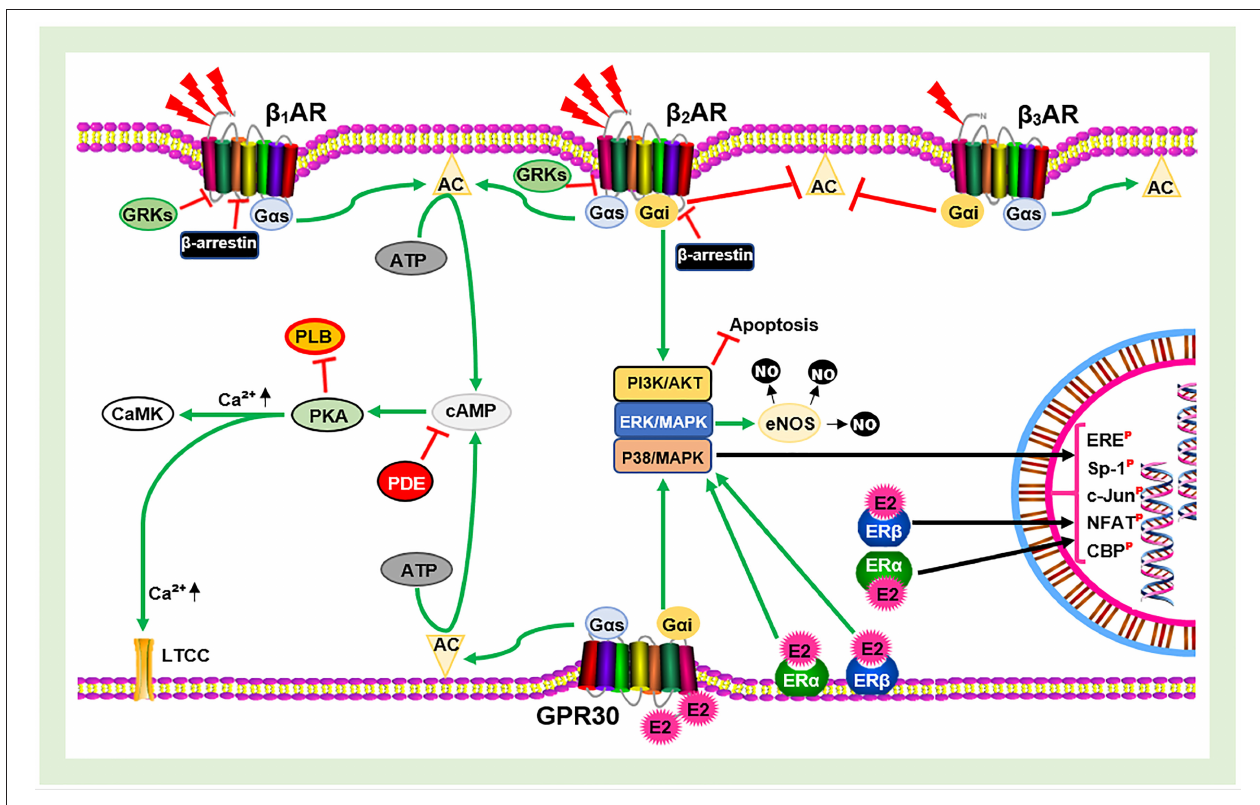
FIGURE 1 | Schematic illustration of estrogen receptors (ERs) and β -adrenergic receptors ( β ARs) signaling. AC, Adenylyl cyclase; cAMP, cyclic adenosine monophosphate; PKA, protein kinase A; GRKs, G-protein-coupled receptor kinases; E2, estrogen; eNOS, endothelial nitric oxide synthase; NO, nitric oxide; PDE, phosphodiesterase; PLB, phospholamban; LTCC, L-type calcium channel; CaMK, calmodulin-dependent kinase; ERE, estrogen receptor element; Sp-1, stimulating protein-1; NFAT, nuclear factor of activated T cells; , Phosphorylated; , Inhibit; , Upregulate; ,